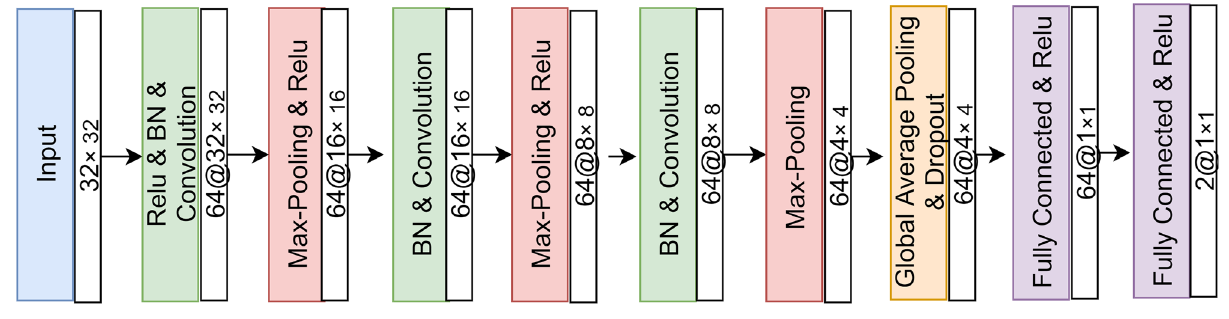
Figure 2. The structure of the CNN used in this